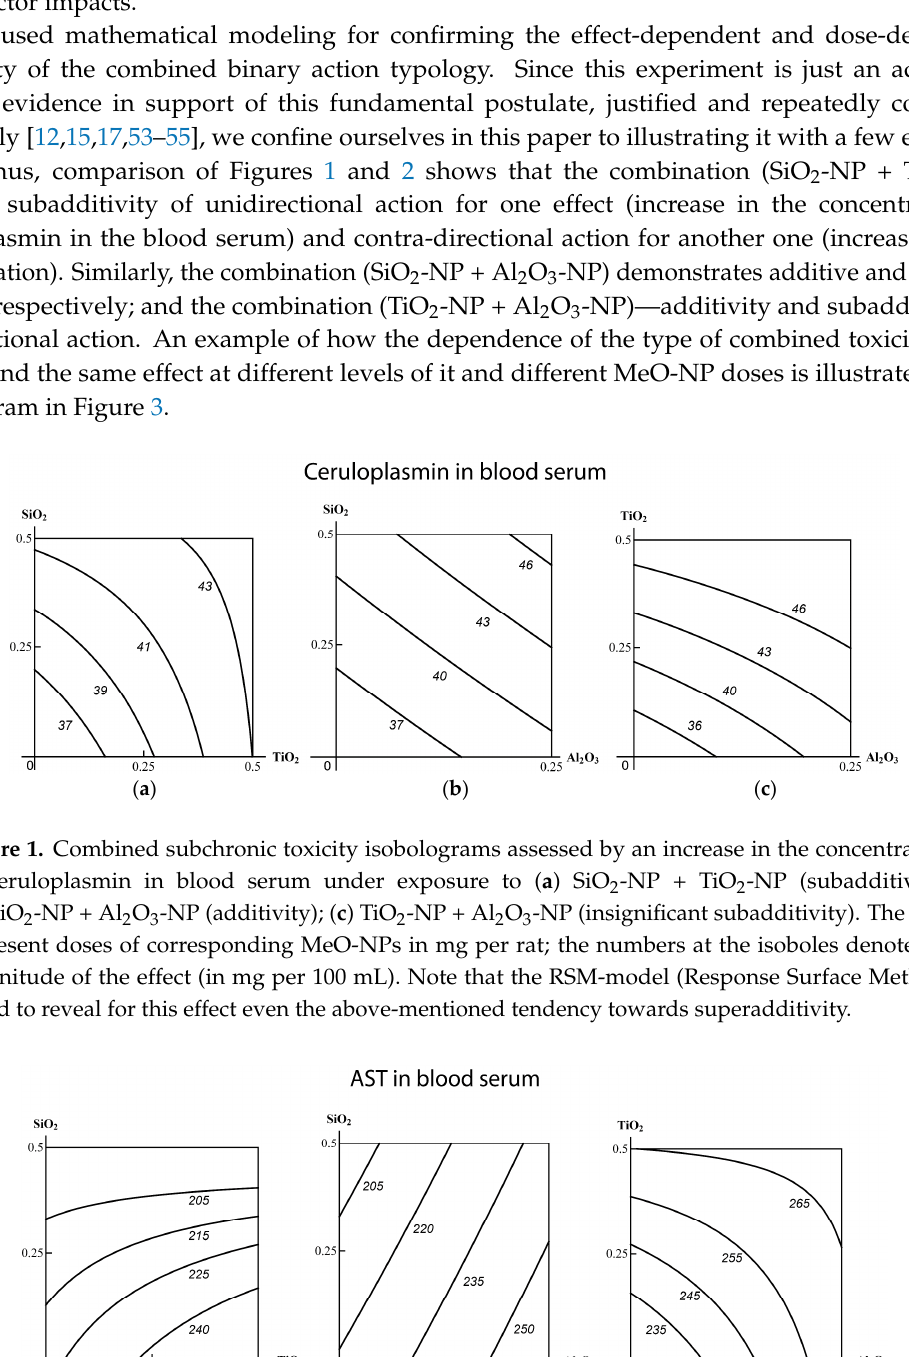
Figure 2. Combined subchronic toxicity isobolograms assessed by an increase in the concentration of AST in blood serum under exposure to ( а ) SiO 2 -NP + TiO 2 -NP (opposite action); ( b ) SiO 2 -NP + Al 2 O 3 -NP (opposite action); ( c ) TiO 2 -NP + Al 2 O 3 -NP (subadditivity of unidirectional action). The axes represent doses of corresponding МеО -NPs in mg per rat; the numbers at the isoboles denote the magnitude of the effect (in IU/L).